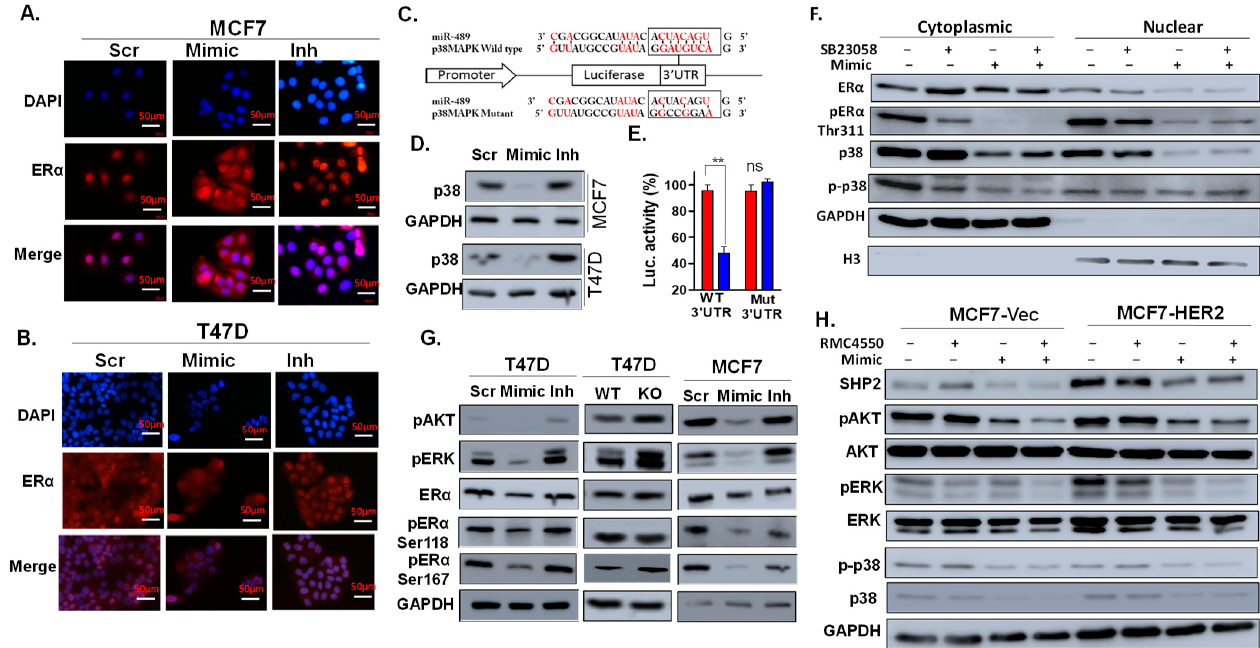
Figure 5. miR-489 inhibits estrogen-induced signaling by inhibiting p38 MAPK, PI3K-AKT, and MAPK-ERK pathways. ( A , B ) MCF7 and T47D cells were transfected with a scramble, mimic, or inhibitor for 72 h in estrogen-deprived media, followed by estrogen stimulation for 15 min. The data represent the localization of estrogen receptors using immunofluorescence. ( C ) miR-489 binding site in p38 MAPK 3 ′ UTR. ( D ) A scramble, mimic, or inhibitor was transfected, and Western blot analysis was performed to examine the total p38 MAPK protein. ( E ) 3 ′ UTR transfection assay showing that miR-489 directly bound to 3 ′ UTR of p38 MAPK. Data are means of three replicates + SEM. ns, not significant; ** p < 0.01. ( F ) MCF7 cells were transfected with a scramble or mimic in the presence of DMSO or the p38 MAPK inhibitor, SB23508. At 72 h post-transfection, cytoplasmic and nuclear frac- tionations were prepared for Western blot analysis of expression and phosphorylation statuses of ER α and p38. ( G ) Cells were transfected with a scramble, mimic, or inhibitor for 72 h, and ER α phosphorylation and responsible kinases were examined using Western blot analysis. ( H ) MCF7 cells were transfected with a scramble or mimic in the presence of DMSO or SHP2 allosteric inhibitor RMC4550. ER α phosphorylation and responsible kinases were examined using Western blot analy- sis.